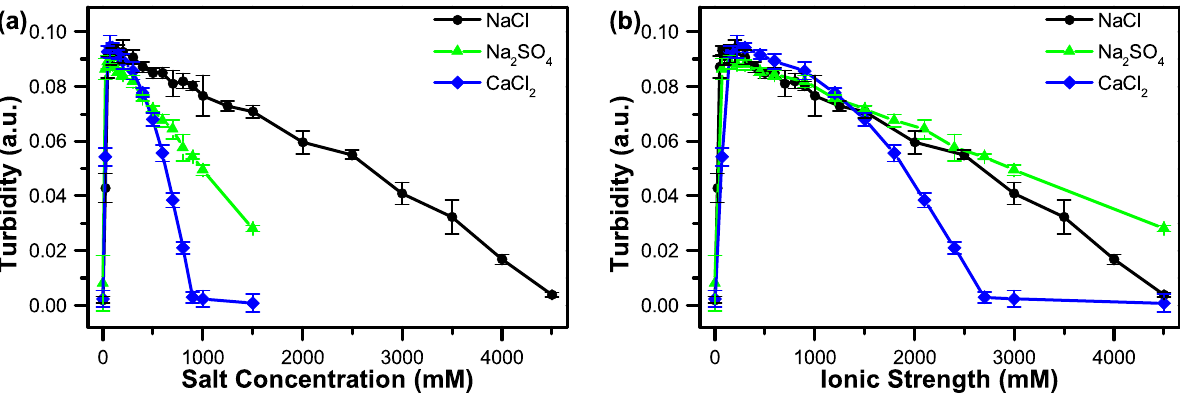
Figure 3. Plots of turbidity as a function of ( a ) salt concentration and ( b ) ionic strength for a selection of monovalent and divalent salts. All samples were prepared at 1 mM total monomer concentration, 50/50 mol% pAA/pAH ratio at pH 6.5. Complexes were prepared by adding pAA to a solution containing a mixture of pAH and the desired quantity of